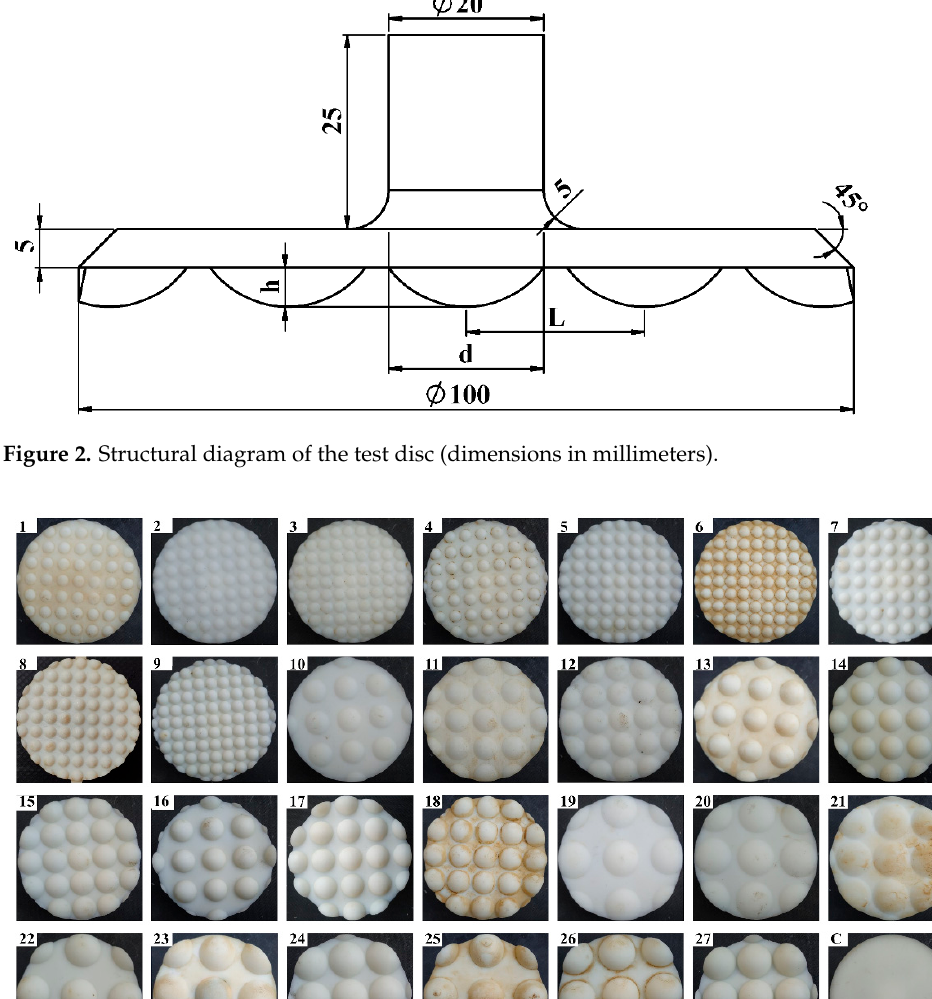
Figure 4. Experimental setup for the sliding resistance test: ( a ) the sieved soil; ( b ) creating an appro- priate soil bin to test sliding resistance; ( c ) flattening and smoothing of soil surfaces; ( d ) exposing the soil paste to constant normal stress of 1025 N·m − 2 for one minute; ( e ) pulling the test disc for 40 cm of soil bin length. 2.3. Drag Force Test The drag force of each test disc was measured using a TMS-PRO texture analyzer (food technology corporation of the United States) equipped with a 1000 N load cell, 0.1 N accuracy, and a moving speed range of 0.1–500 mm min − 1 . Drag force tests were conducted in two consecutive phases, namely, the loading phase and the drag phase. The loading phase intended to sink the entire dome height